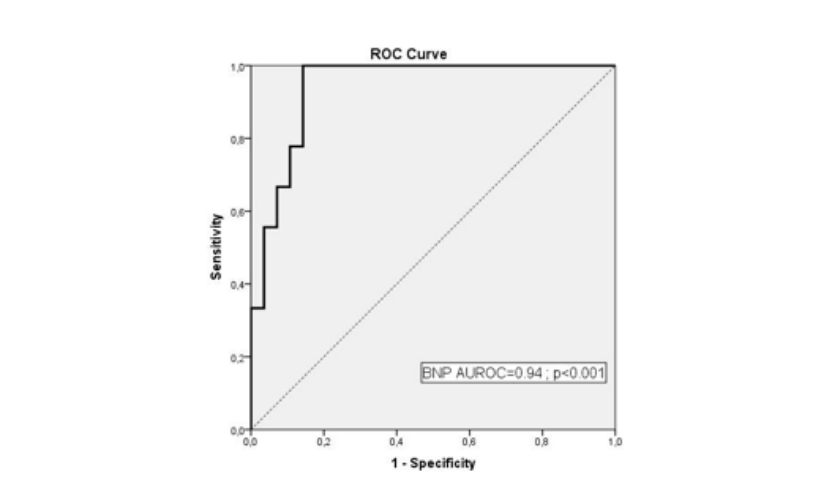
Figure 3. ROC curve for the accuracy of BNP in the diagnosis of decompensated heart failure in patients with muscular dystrophies. ROC, receiver operating characteristic; BNP, brain natriuretic